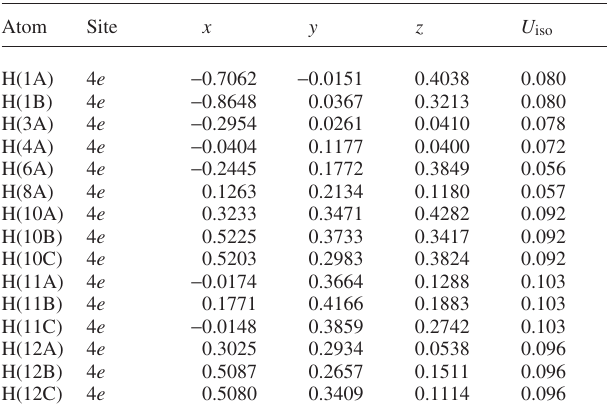
Table 2. Atomic coordinates and displacement parameters (in Å 2 )